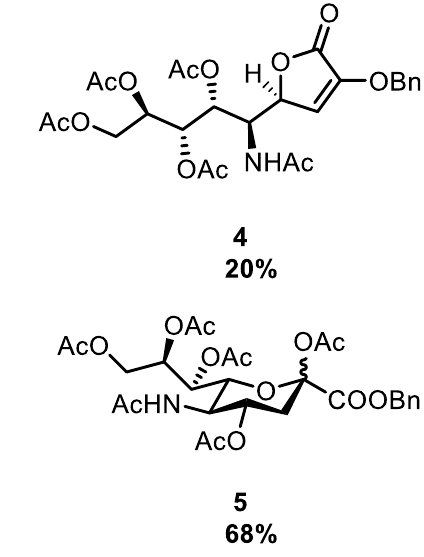
Figure 2. Preparation of a protected 1,4 lactone from Neu5Ac.